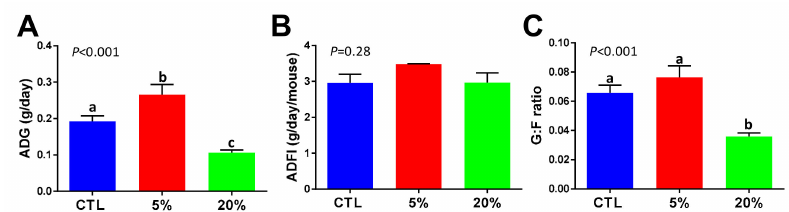
Figure 1. Influences of Scenedesmus feeding on growth performance. The body weight gain and feed intake of three groups of mice, control (CTL), 5% Scenedesmus , and 20% Scenedesmus , were monitored during a 28-day feeding period. ( A ) Average daily gain (ADG). ( B ) Average daily food intake (ADFI). ( C ) Gain to feed ratio (G:F). P -values indicate overall significances across all sample groups from the one-way ANOVA test. Means with di ff erent letter labels (a,b,c) indicate significant di ff erences ( P < 0.05) between two dietary treatments by the Tukey post hoc